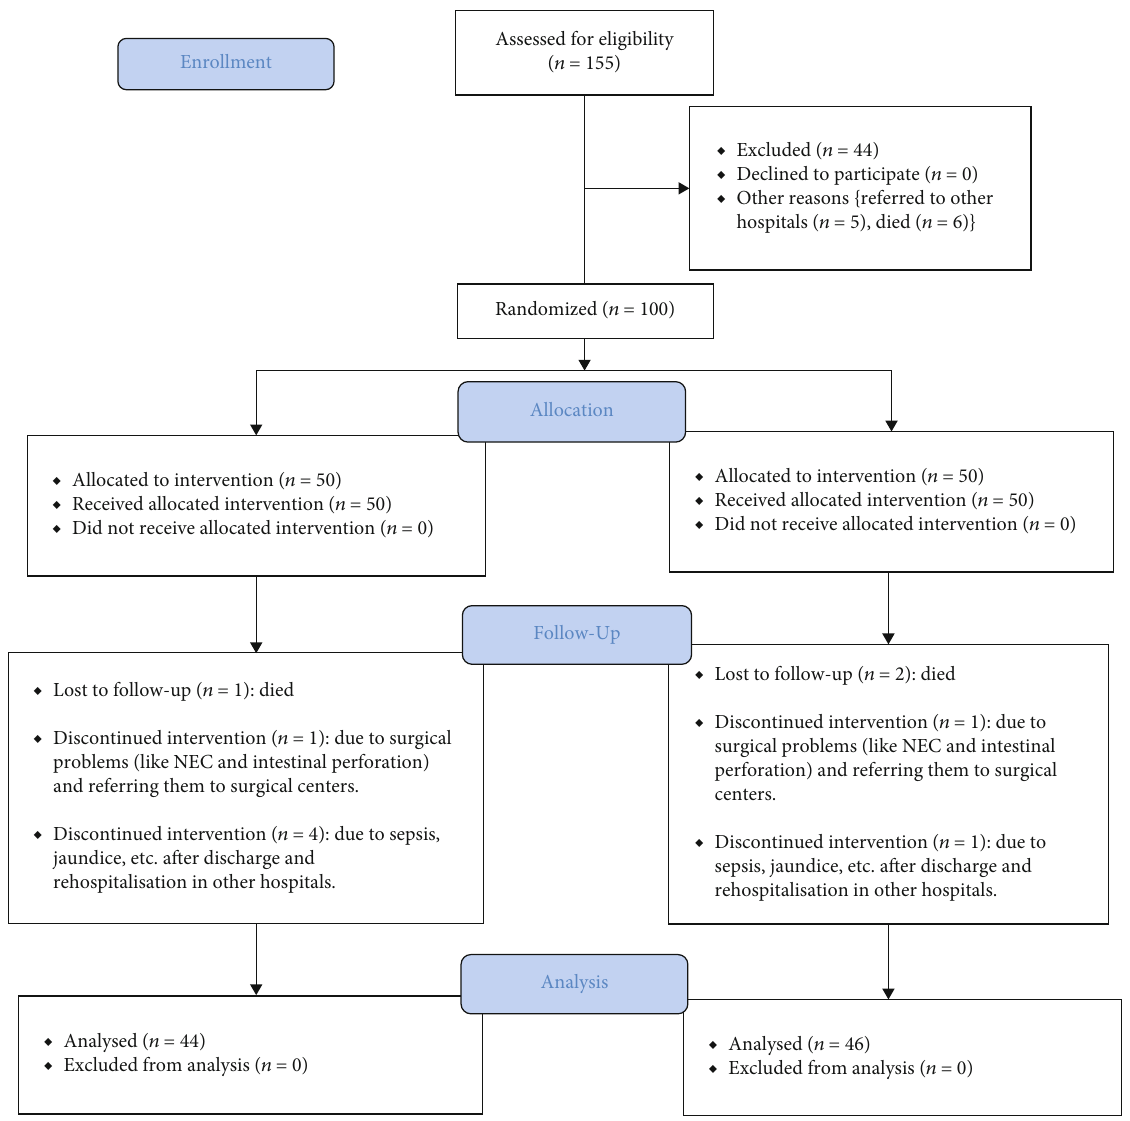
Figure 1: CONSORT fl ow diagram. Table 2: Comparison of study outcomes between early and late ca ff eine groups. Study